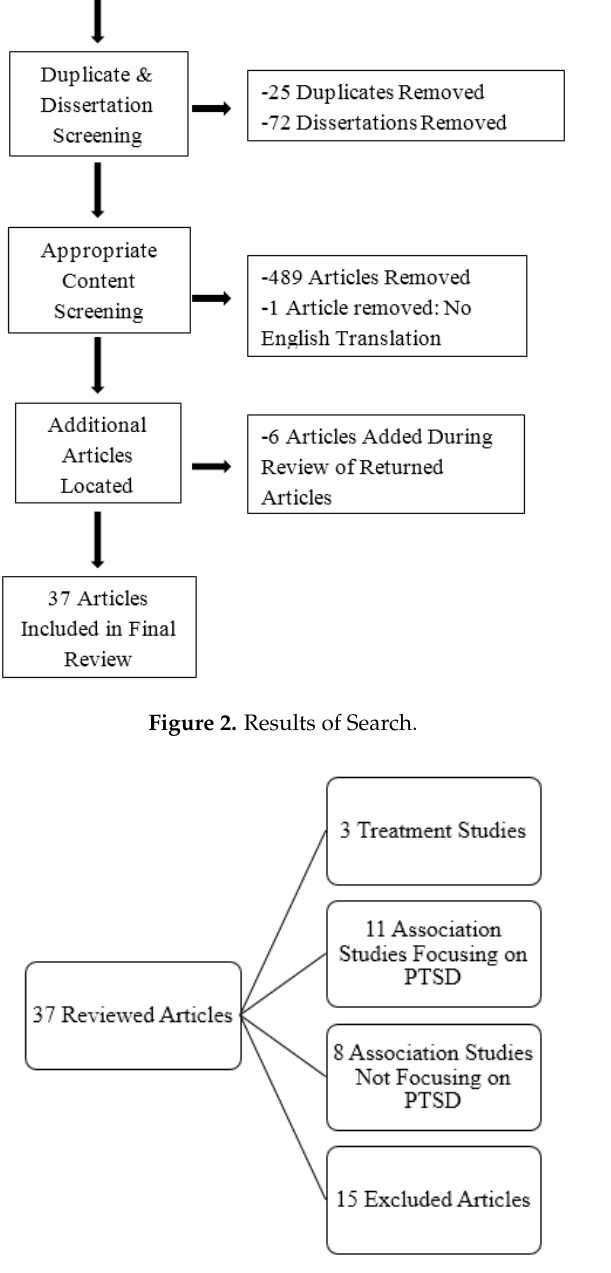
Figure 3. Themes and number of studies included in final review.